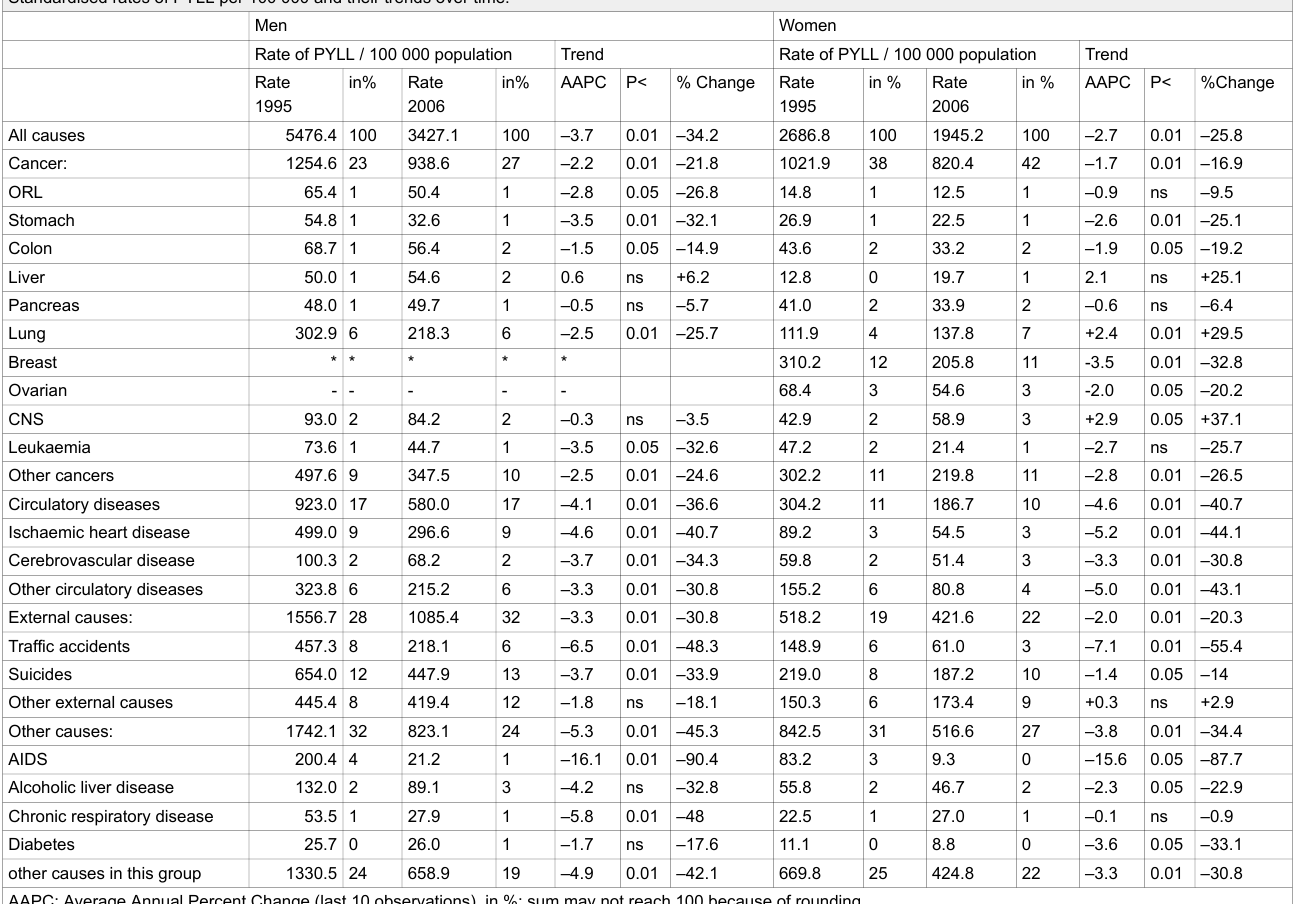
Table 2 Standardised rates of PYLL per 100 000 and their trends over